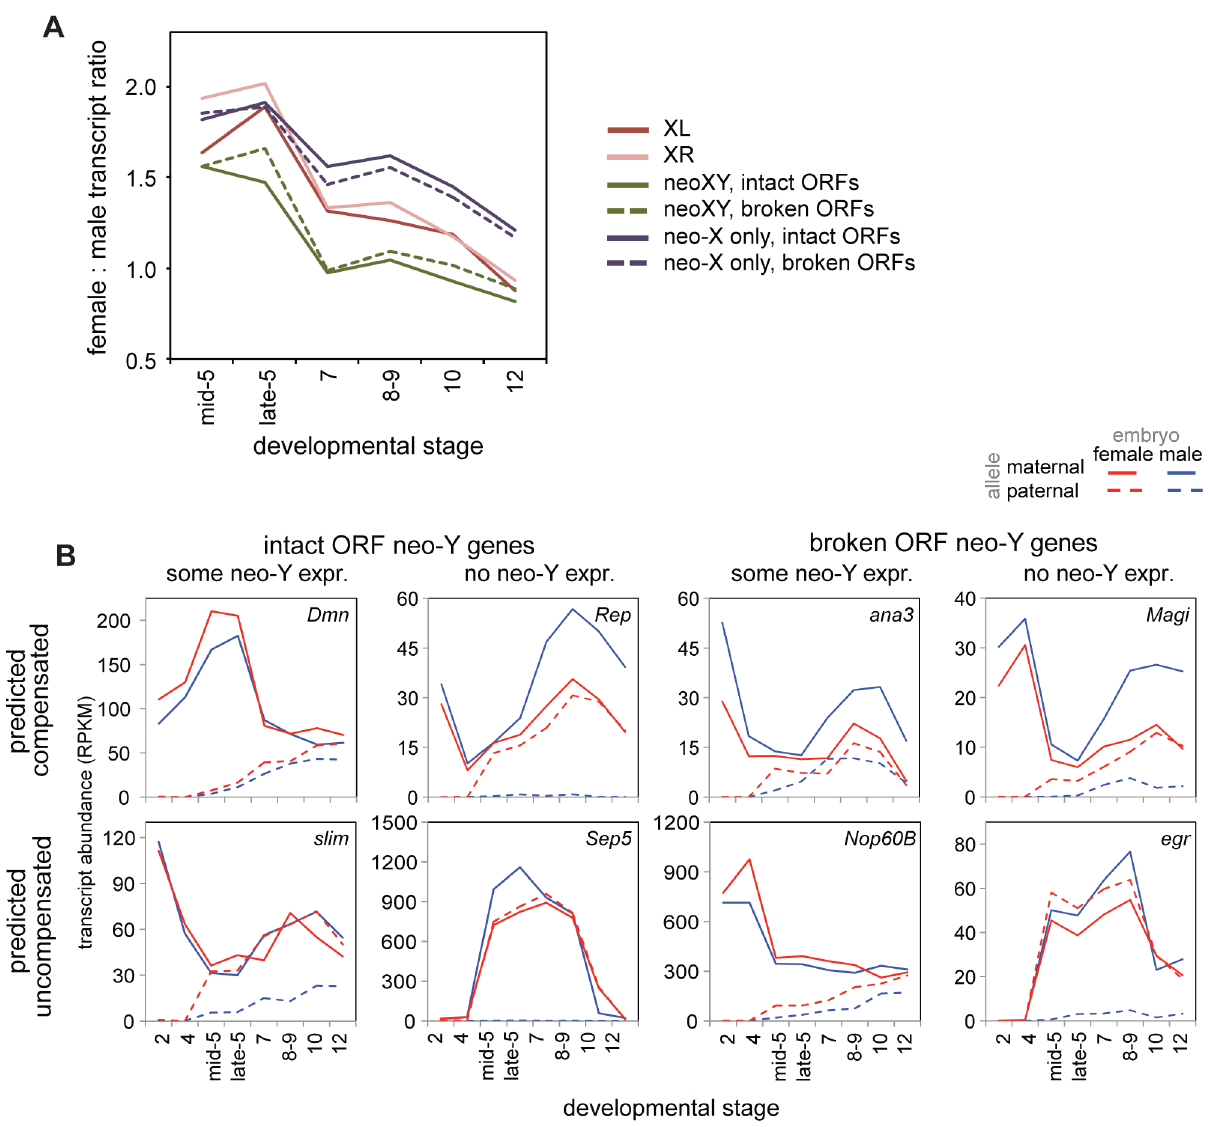
Figure 6. The neo-XY of D.miranda and the evolution of dosage compensation in the embryo. A) Female to male transcript ratios over stages for zygotic genes (allele-specific definition, see Methods) on the neo-XY (with transcripts from both the neo-X and neo-Y included), and for just the neo-X, both broken down by whether the neo-Y copy of that gene is predicted to be functional (intact ORF) or non-functional (broken ORF). See table S12 for Wilcoxon p-values comparing chromosomes over stages. B) Example genes from the neo-XY, with allele-specific transcript abundances. Every combination of predicted functionality of the neo-Y (with the assumption that genes with intact ORFs are functional, genes with broken ORFs are nonfunctional), contribution of neo-Y transcript, and predicted compensation status (relative to the predicted functionality of the neo-Y copy of the gene) is observable.